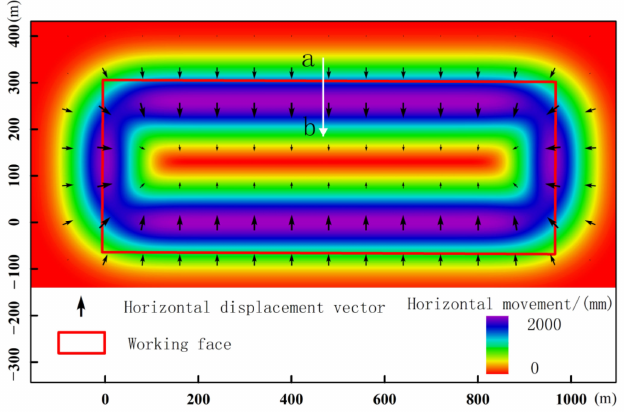
Figure 9. Characteristics of surface horizontal displacement